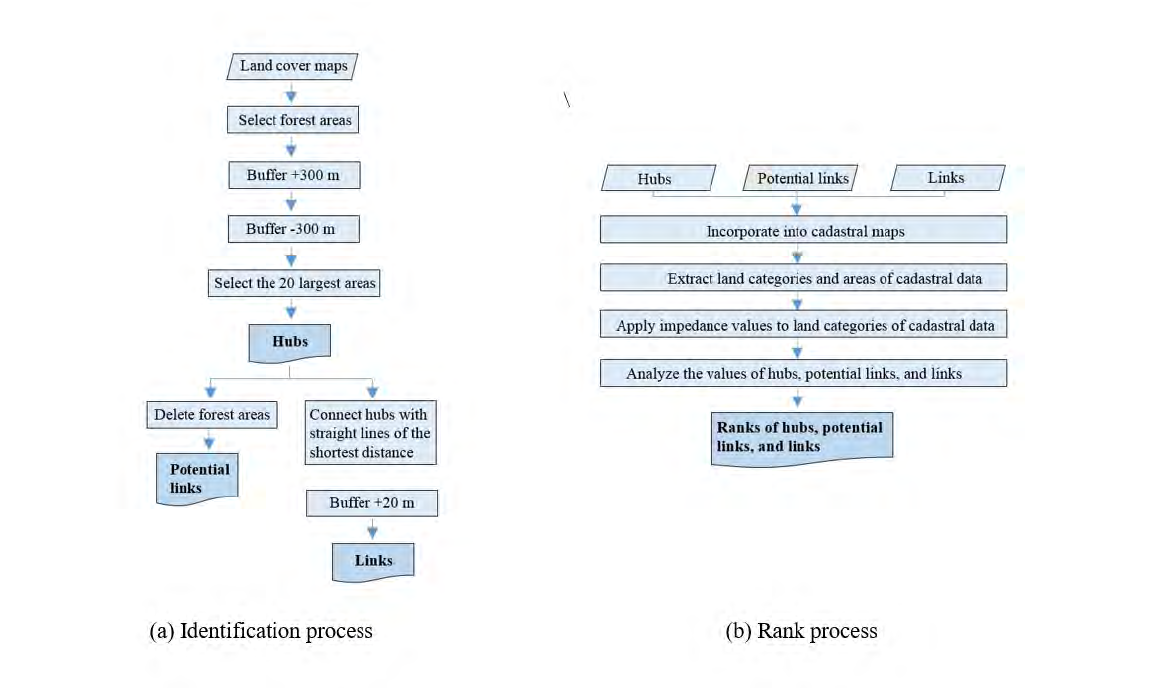
Figure 1. Identification and rank processes of elements of green infrastructure